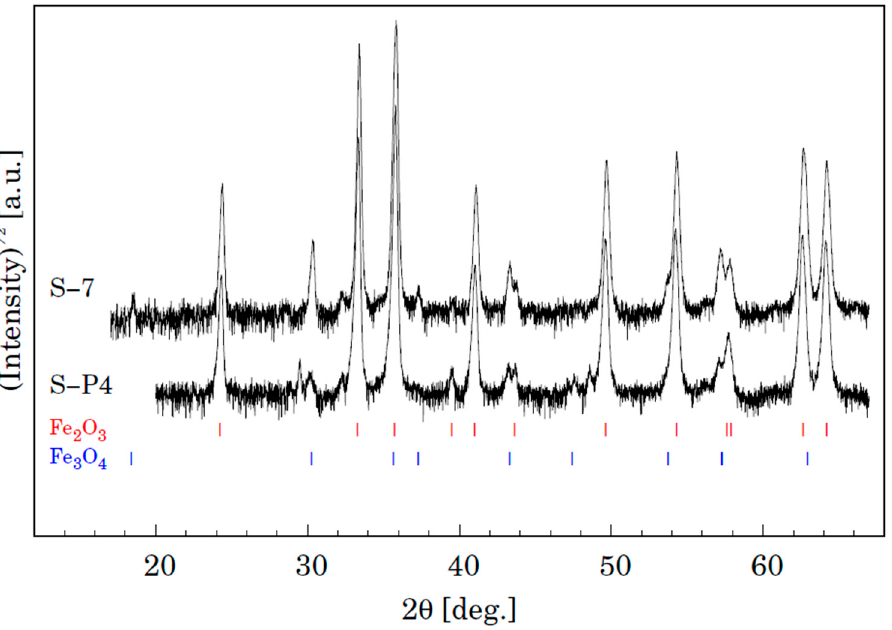
Figure 14. XRD patterns for samples S-P4 (P91) and S-7 (MarBN) oxidized for 3000 h at 600 °C. Vertical lines shown at the bottom depict positions of Bragg reflections belonging to Fe 2 O 3 and Fe 3 O 4 .